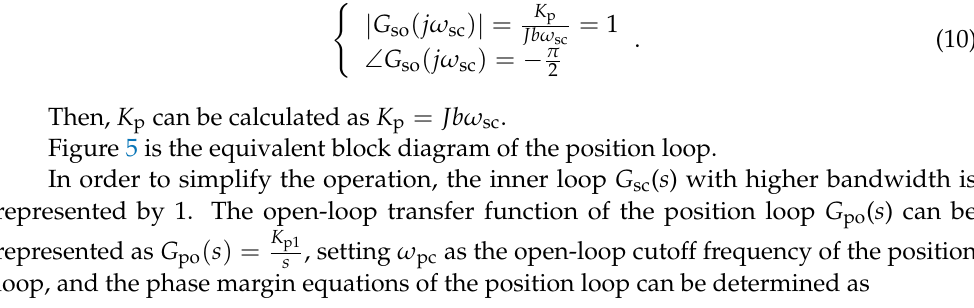
Figure 5 is the equivalent block diagram of the position